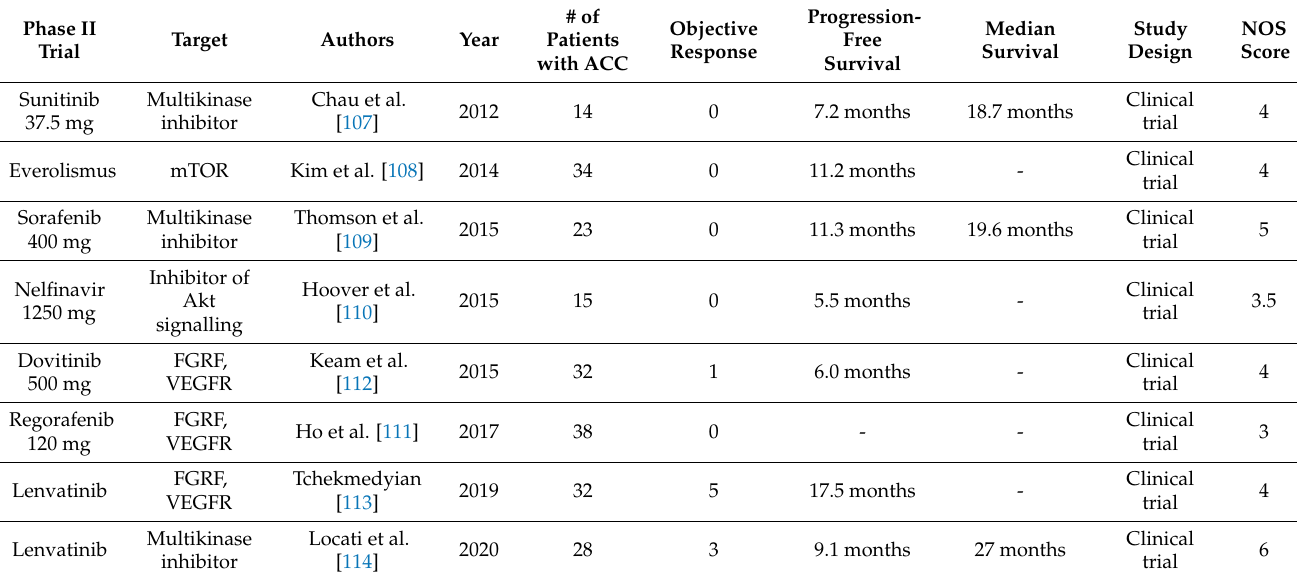
Table 2. Clinical phase II trials investigating systemic molecular biological therapeutic approaches between 2012 and 2022. # means